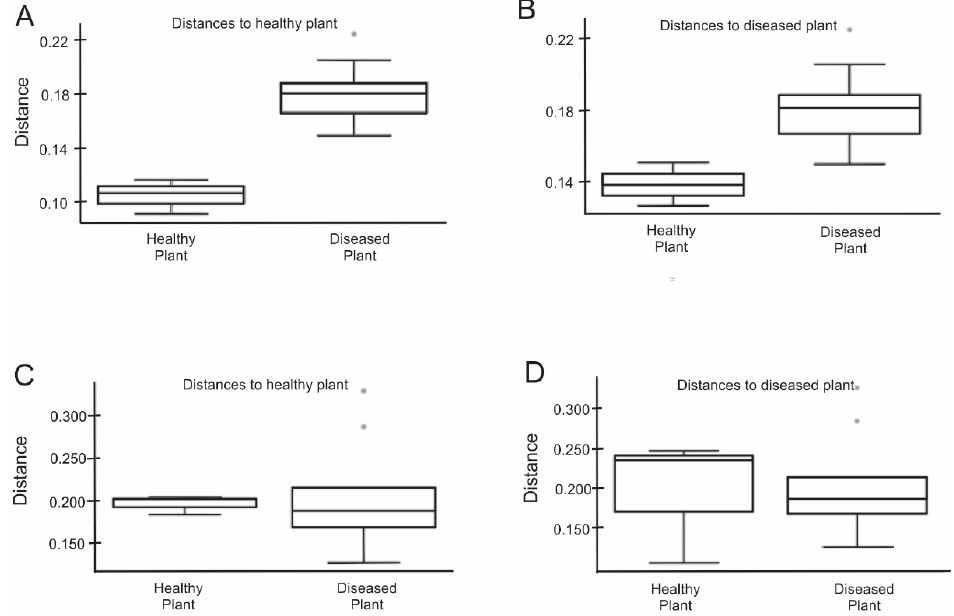
Figure 2. Significant differences in microbial community composition between healthy and diseased rhizosphere microbiome through UniFrac ANOSIM analysis. ( A ) Unweighted UniFrac distance to healthy plant; ( B ) unweighted UniFrac distance to diseased plant; ( C ) weighted UniFrac distance to healthy plant; ( D ) weighted UniFrac distance to diseased plant. *, ** : sample outlier.